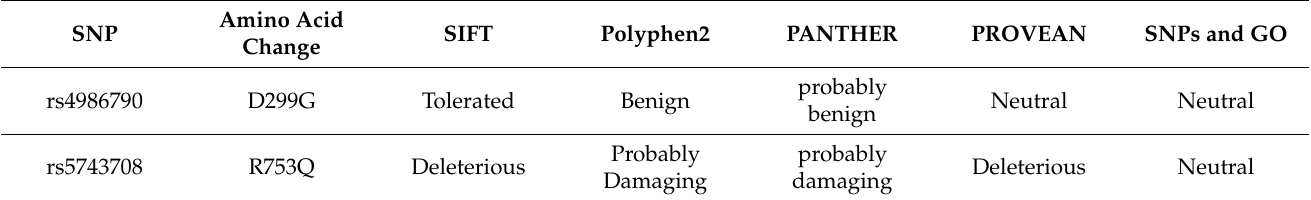
Table 1. Predicting the effect of SNPs on protein function using bioinformatics